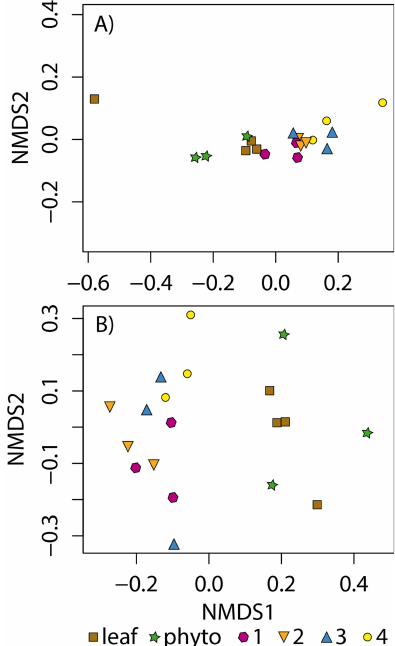
resenting differences between the phytoplankton (phyto) and leaf leachate single incubations and the four treatments of (A) phospholipid-derived fatty acids (PLFA) concentration patterns and (B) denaturing gradient gel electrophoresis (DGGE) banding pat- terns. Bray–Curtis dissimilarities were calculated for the concen- trations of 13 different PLFA and for banding patterns (Sørensen similarity coefficient) from DNA amplified with general eubacterial primers of each treatment and triplicate at the end of the experiment. The stress value is A = 0.013 and B =